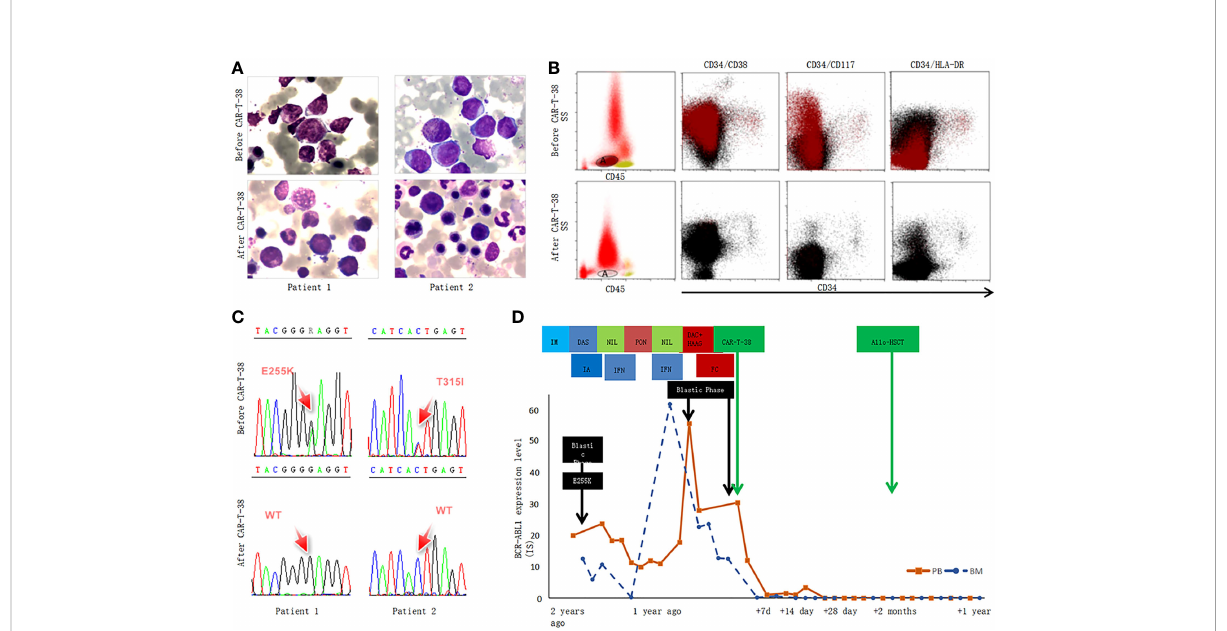
FIGURE 1 CAR-T-38 therapy response in the two patients with CML-BP. (A) This part showed the bone marrow morphological feature of patients 1 and 2 before (up) and 2 weeks after CAR-T-38 treatment (upper lower). After CAR-T-38 cell infusion, the patient 1 (left, lower) and 2 (right, lower) achieved CR. (B) The blasts were gated by using a CD45, side scatter (SS), and CD34-based gating strategy, but CD34 + leukemia had lost CD34 expression as the disease progressed to BP in these two patients, and the blasts were gated according to CD45/SS gating strategy (left). The blast (A population, tomato red) rates of bone marrow mononuclear cells (blank, middle and right plots) were 28.8% and 7.3 × 10 − 4 before and 2 weeks after CAR-T-38 treatment, respectively. This CD34 − AML blast fraction expressed CD38, CD117, CD33, CD13, CD123, and HLA-DR. (C) Both E255K and T315I mutation disappeared in bone marrow 2 weeks after CAR-T cell infusion. (D) Dynamic changes of BCR::ABL1 expression level (IS) of patient 1 in the course of the disease. Patient 1 was resistant to multiple TKIs [imatinib (IM), dasatinib (DAS), nilotinib (NIL), and ponatinib (PON)], intensive chemotherapy with idarubicin and cytarabine (IA), and interferon- a (IFN). The level of BCR::ABL1 was reduced to 0, 1 week after CAR-T